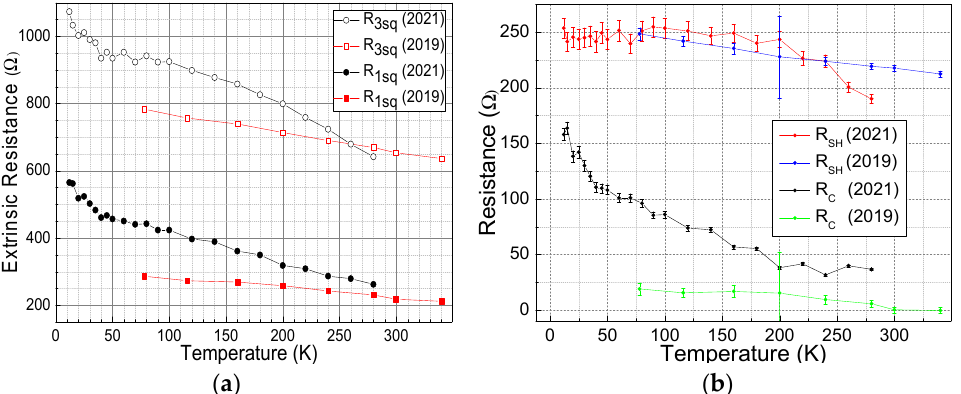
Figure 2. Two sets of the Cu-TiN x O y thin film resistors R(T) measurements taken 18 months apart in the year 2019 and 2021, accordingly. The width/thickness is 30 µm/22 nm, and the lengths are 30 µm and 90 µm for the 1-square and 3-square resistors, respectively. The resistors are as follows: ( a ) extrinsic (measured) resistance and ( b ) extracted Cu-TiN x O y sheet ( R SH ) and TiN x O y /Ti/Cu contact ( R C ) resistances.